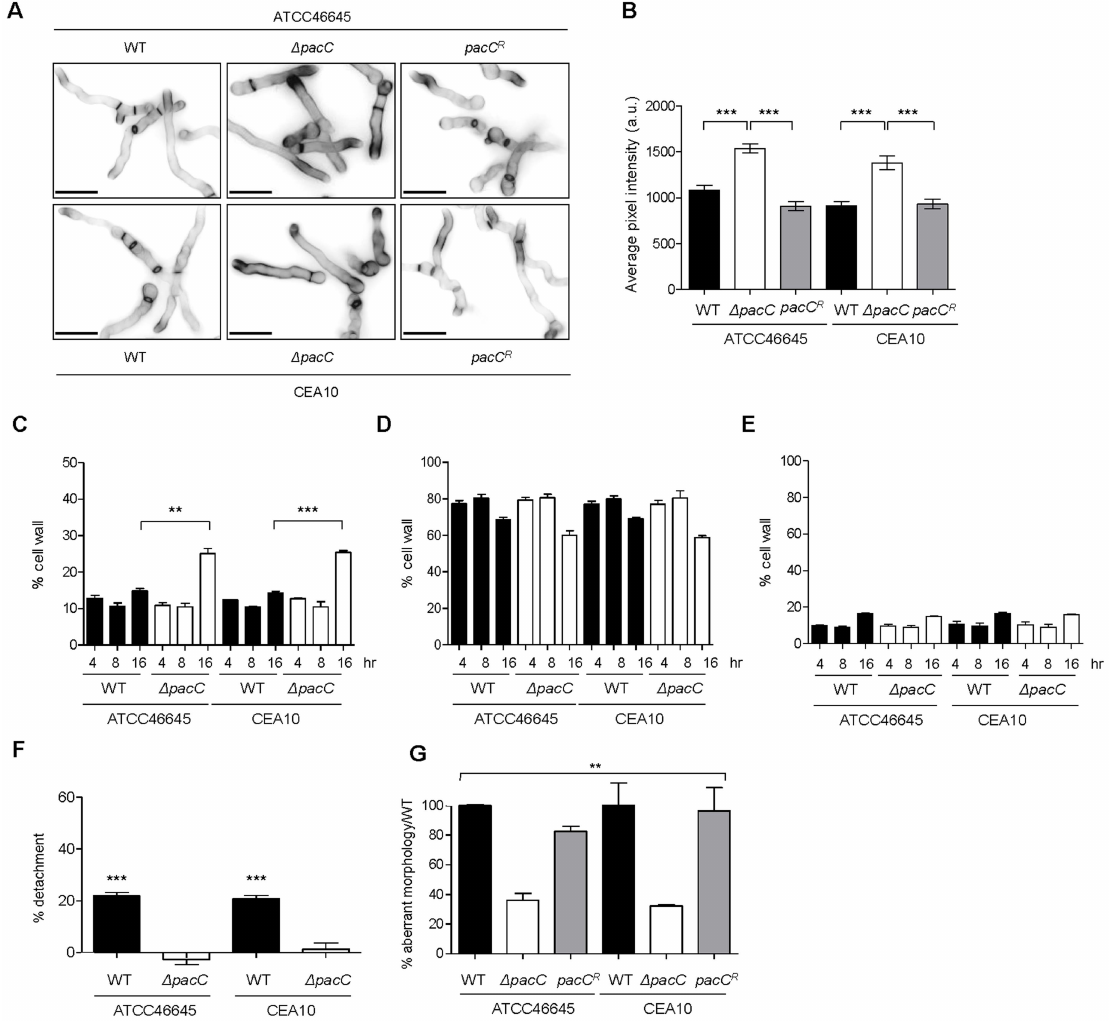
Figure 5. Aberrant morphology of A.fumigatus D pacC mutants impacts contact-mediated epithelial decay. (A) Calcofluor white staining of A. fumigatus strains after growth for 17–18 hr in AMM (pH 6.5) at 28 u C. (B) Quantification of calcofluor white-mediated fluorescence (arbitrary units) as measured from panel A. (C) Percentage, in cell wall extracts relative to total weight, of chitin. (D) Percentage, in cell wall extracts relative to total weight, of glucan. (E) Percentage, in cell wall extracts relative to total weight, of mannan. (F) Percent detachment, relative to PBS challenge, of A549 cells after co-incubation with cell wall extracts (10 m g/ml). Significance was calculated relative to PBS-challenged monolayers. (G) Percent aberrant morphology, amongst thimerosal-killed fungus-proximal ECs, per unit of hyphal length, relative to wild-type challenged monolayers. B and C: biological and technical triplicates. D and E: performed twice in triplicate. B, C and D: unpaired t test. E: 1-way ANOVA test. *** p , 0.001 and ** 0.001 , p ,